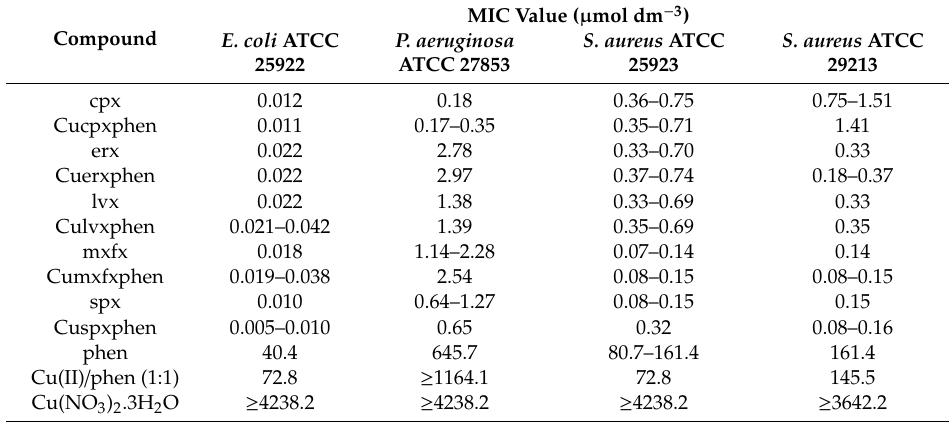
Table 1. Minimum inhibitory concentration (MIC) values of several FQs, CuFQphen complexes, phen, Cu(II) / phen (1:1) and Cu(NO 3 ) 2 .3H 2 O salt against reference strains, E. coli ATCC 25922, P. aeruginosa ATCC 27853, S. aureus ATCC 25923 and S. aureus ATCC 29213. Values presented were obtained from